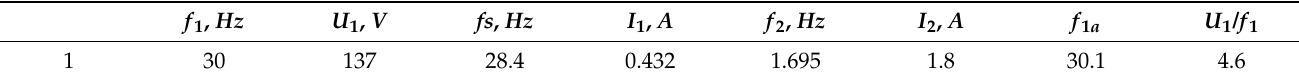
Table 3. At low load, the load drive is switched off.